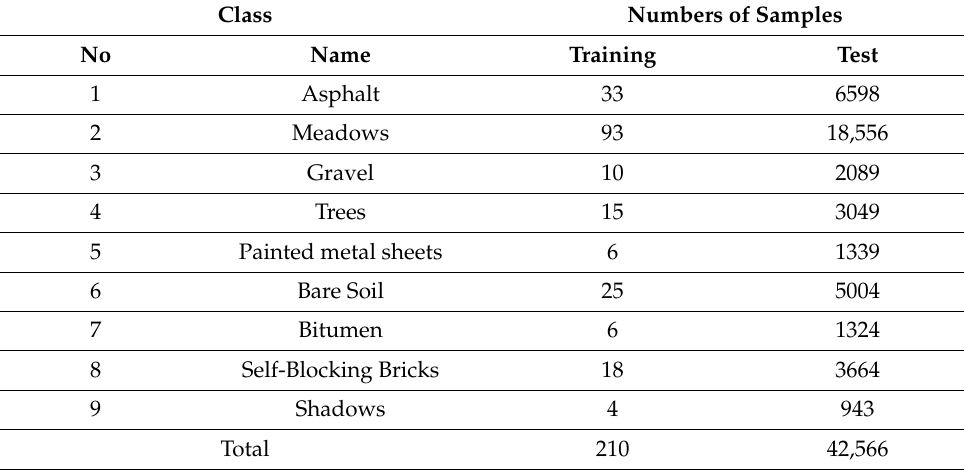
Table 3. Number of training and test samples in the UP data